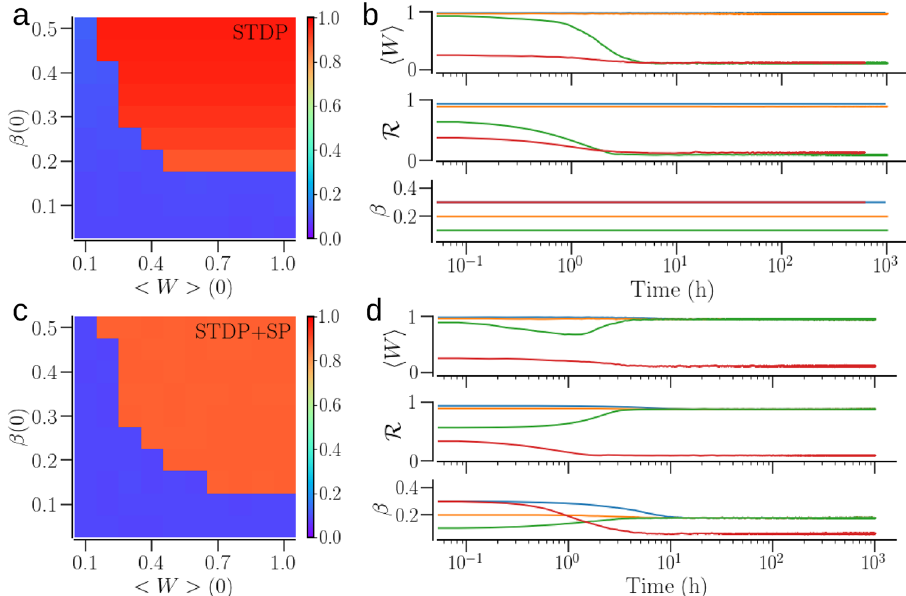
Figure 5. The asymptotic states for a network of identical oscillators (with ω i = 2 π f 0 ) and their basins of attraction in the two plasticity schemes considered—STDP and STDP + SP. ( a , b ) Refer to a network with STDP only; panels ( c , d ) correspond to the network with STDP + SP. The colors in ( a ) and ( c ) indicate the values of the order parameter, R , in the asymptotic states when the system begins with the initial mean synaptic weight and In-NDD given by (cid:31) W (cid:30) ( 0 ) and β( 0 ) . ( b ) and ( d ) show examples of time evolution of the mean synaptic weight, (cid:31) W (cid:30) , the order parameter, R , and the mean In-NDD, β , for different initial conditions (color coded) as the network transitions to a synchronized or desynchronized state, for STDP and STDP + SP, respectively. Parameters are a = 0.3 , γ = 3